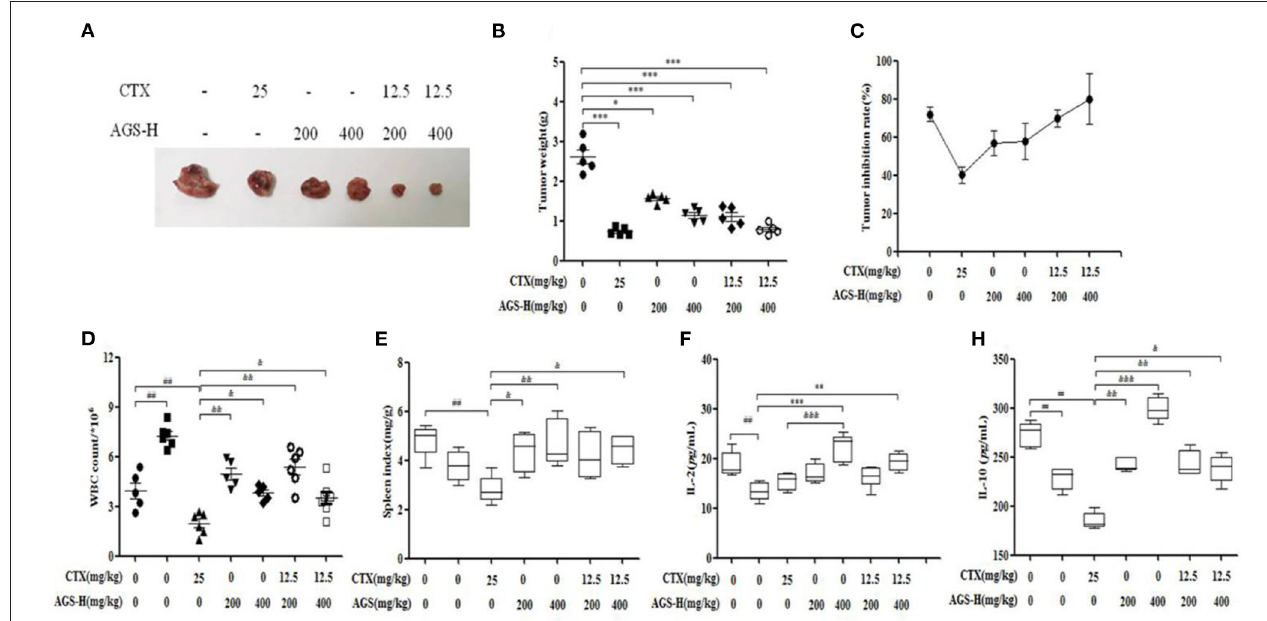
FIGURE 8 | Effects of CTX/2 + AGS-H on tumor inhibition and immune indexes ( n = 8). (A) Tumor image. (B) Tumor weight. (C) Tumor inhibition rate. (D) The white blood cells count. (E) Spleen index. (F) The content of IL-2. (G) The content of IL-10. Values are presented as mean ± SD. vs. normal group, ## P < 0.01; vs. model group, * P < 0.05, ** P < 0.01, *** P < 0.001; vs. CTX group, & P < 0.05 && P < 0.01, &&& P <